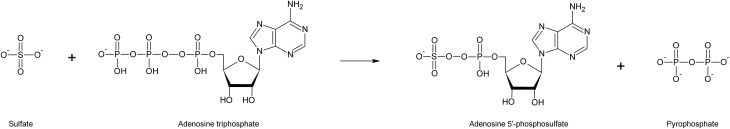
Reaction catalyzed by ATP sulfurylase. The enzyme performs the hydrolysis of the bond between the α- and β-phosphate of ATP and, consequently, the attachment of AMP to SO2−4. MgPPi is finally released.